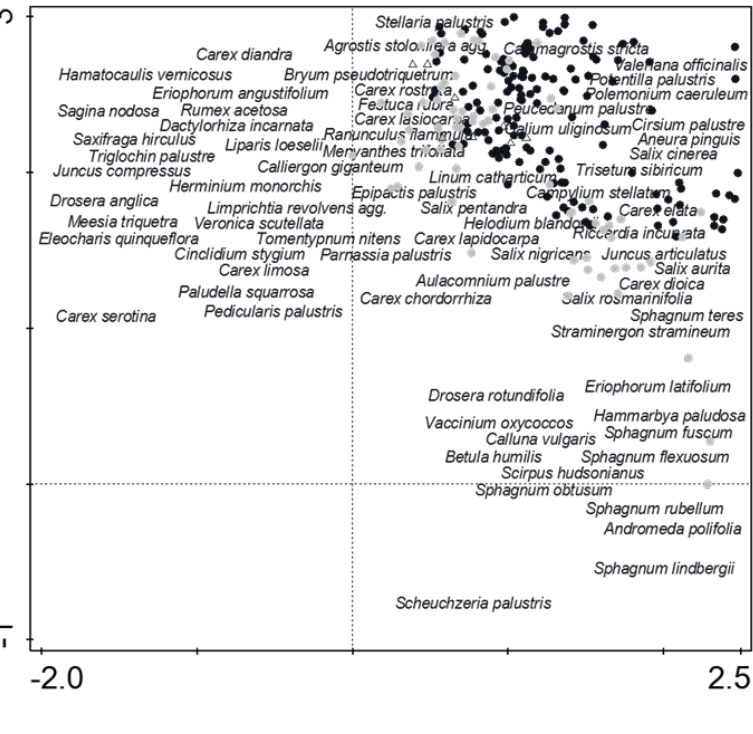
Figure 10. The part of the DCA of vegetation relevés from the Rospuda mire (Figure 9) that includes the brown moss - sedge vegetation type, showing all species. Grey dots: 1980s relevés from Sokołowski (1996); black dots: relevés from the transects recorded in 2006–2008; triangles: additional relevés recorded in 2010–2013. All vegetation layers